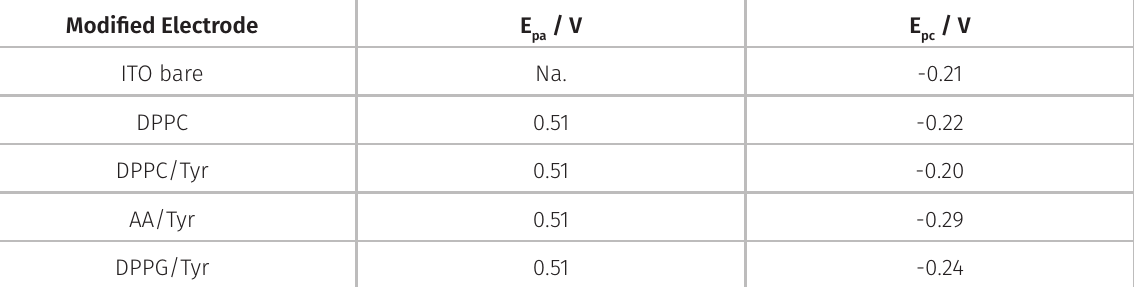
Table I. Potentials of oxidation and reduction of catechol. Modified Electrode E